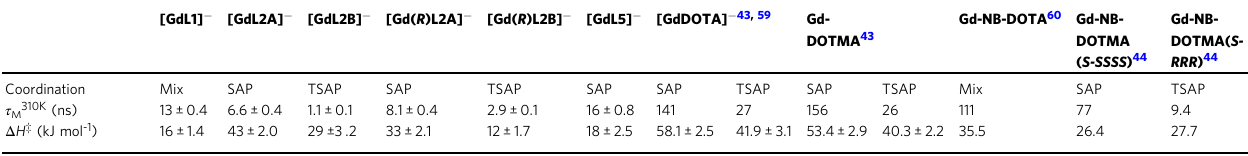
Table 1 Coordination and fi tting parameters 17 O relaxation pro fi